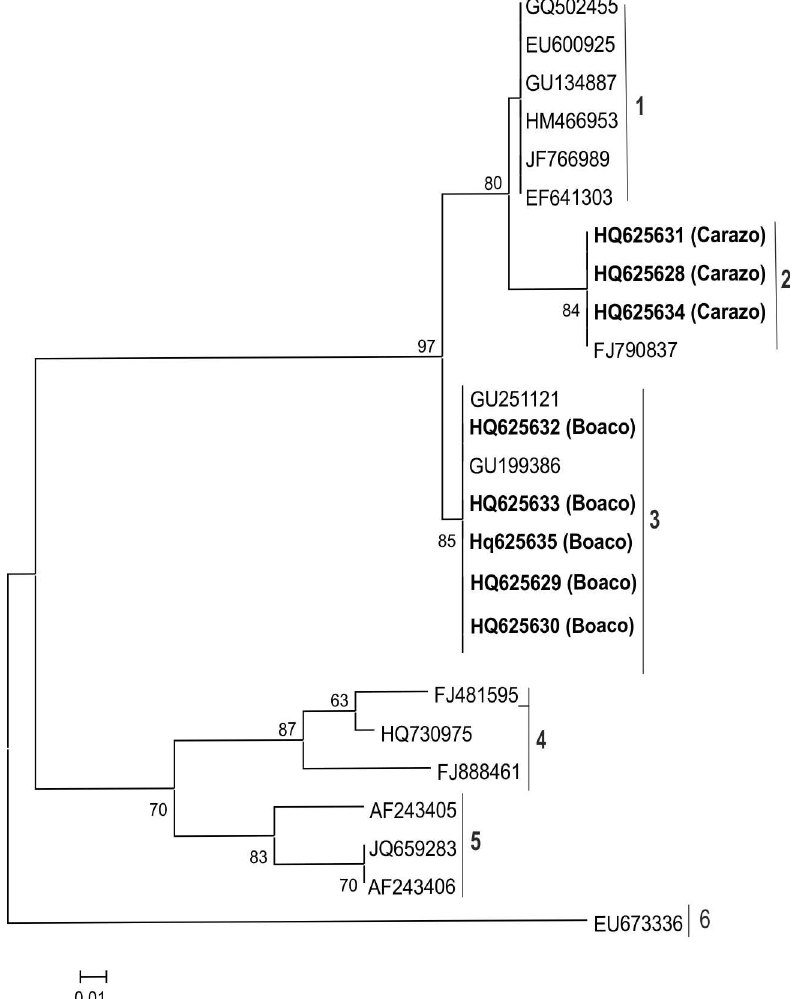
Fig 5. Phylogenetic grouping of the fungal isolates in phenogroup III. Partial ITS1 and the whole 5.8S and ITS2 sequences(~450 nt) of the fungi isolatedfrom beansgrown in Boaco and Carazo (bold letters) were includedin the phylogenetic analysiswith sequencesof Lasiodiplodia theobromae obtained from sequence databases. Numbers at branchesrepresent bootstrapvalues of 1000 replicates. Only bootstrap values (cid:21) 70% are shown. Scale indicates Kimura units in nucleotide substitutionsper